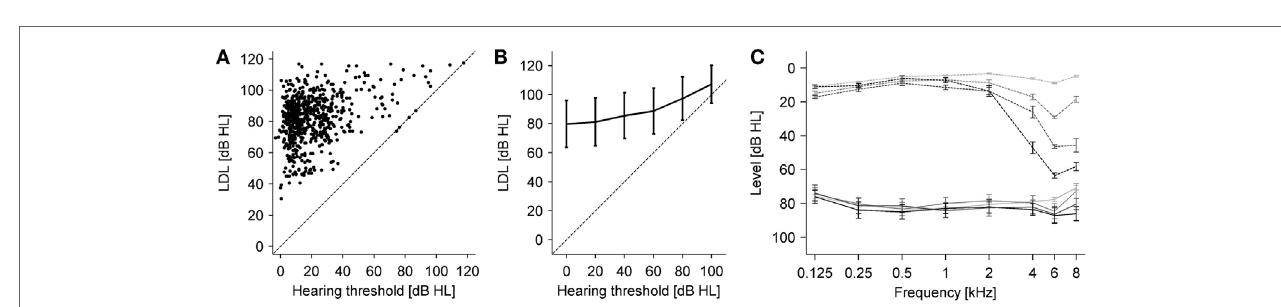
The same relation between hearing thresholds and LDLs was observed in this analysis. Error bars denote ± 1 SD. (c) Average hearing thresholds (dashed lines) and LDLs (solid lines) of patient groups selected for having different degrees of high-frequency hearing loss (see text). The three hearing loss groups had almost identical LDLs in the hearing loss region, which were slightly elevated compared to the group without hearing loss. Error bars denote ±